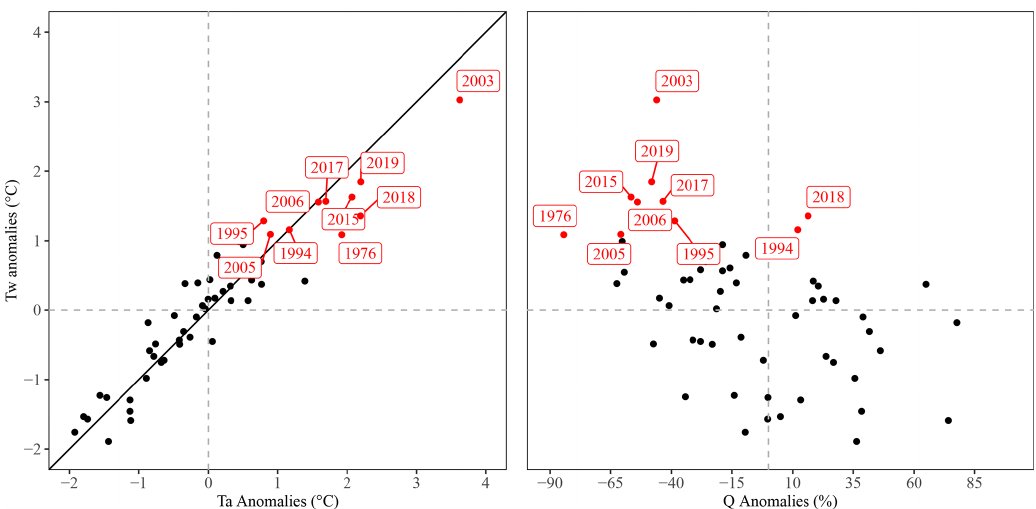
Figure 8. Relationship between summer anomalies in T w and T a on the one hand and summer T w and Q anomalies on the other hand. Indi- vidual years are identified from their median values across all reaches. Years with the highest anomalies in T w ( > + 1 ◦ C) and corresponding anomalies in T a and Q are identified in red.